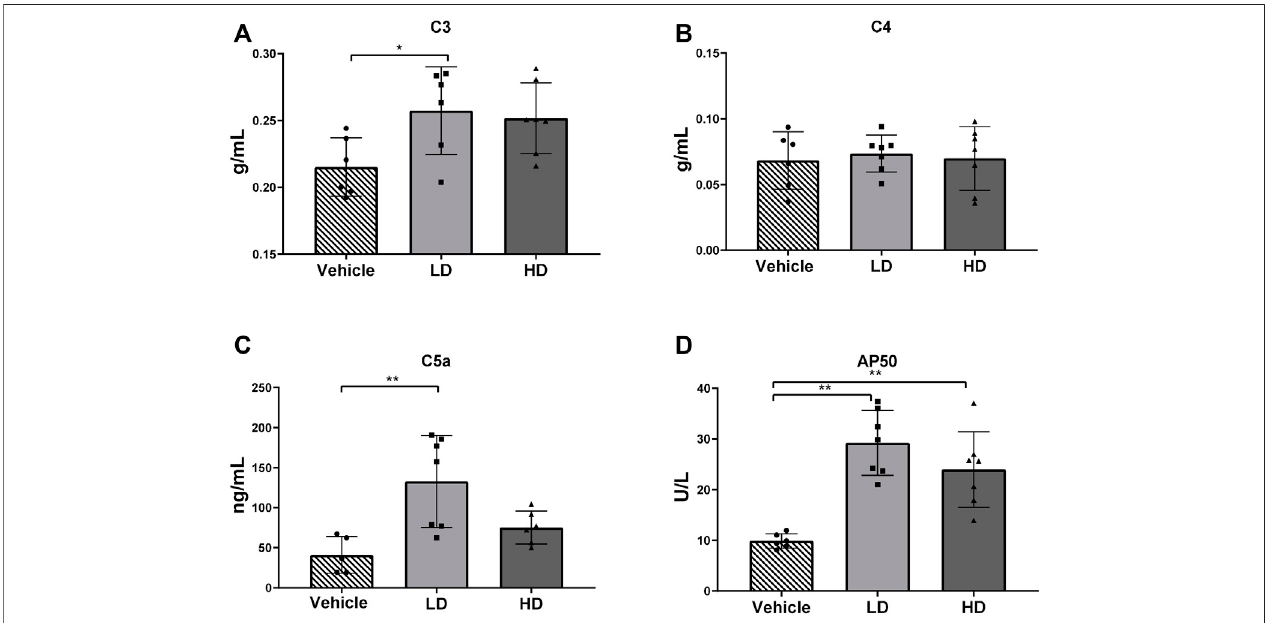
FIGURE 6 | TM-induced ERS triggers complement activation in piglets. Piglets were administered with TM LD (0.1 mg/kg body weight), HD (0.3 mg/kg body weight), or vehicle for 48 h. (A – D) Plasma level of C3, C4, C5a, and AP50 in different groups. * means p < 0.05; ** means p < 0.01.